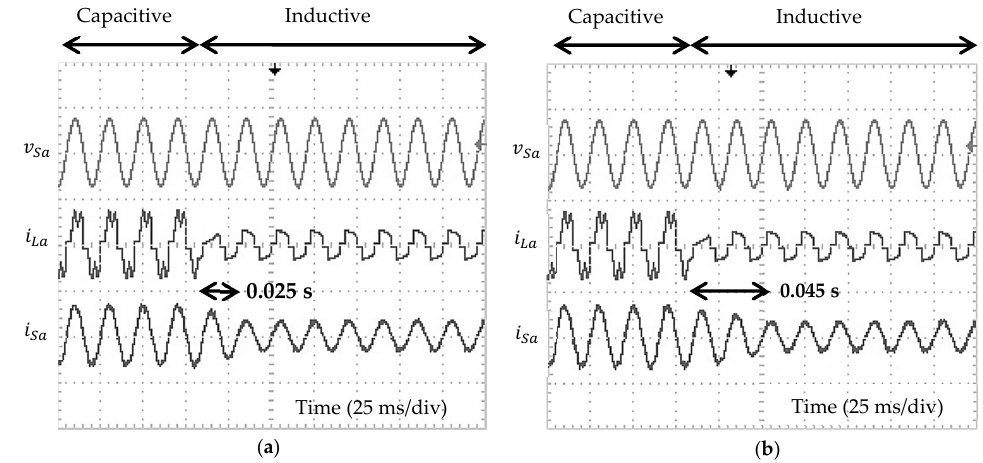
Figure 11. Experimental result showing phase a source voltage v Sa (100 V/div), phase a load current i La (10 A/div) and phase a source current i Sa (10 A/div), demonstrated by SAPF while applying: ( a ) the proposed algorithm; and ( b ) the existing algorithm, for dynamic-state condition of capacitive to inductive loads.